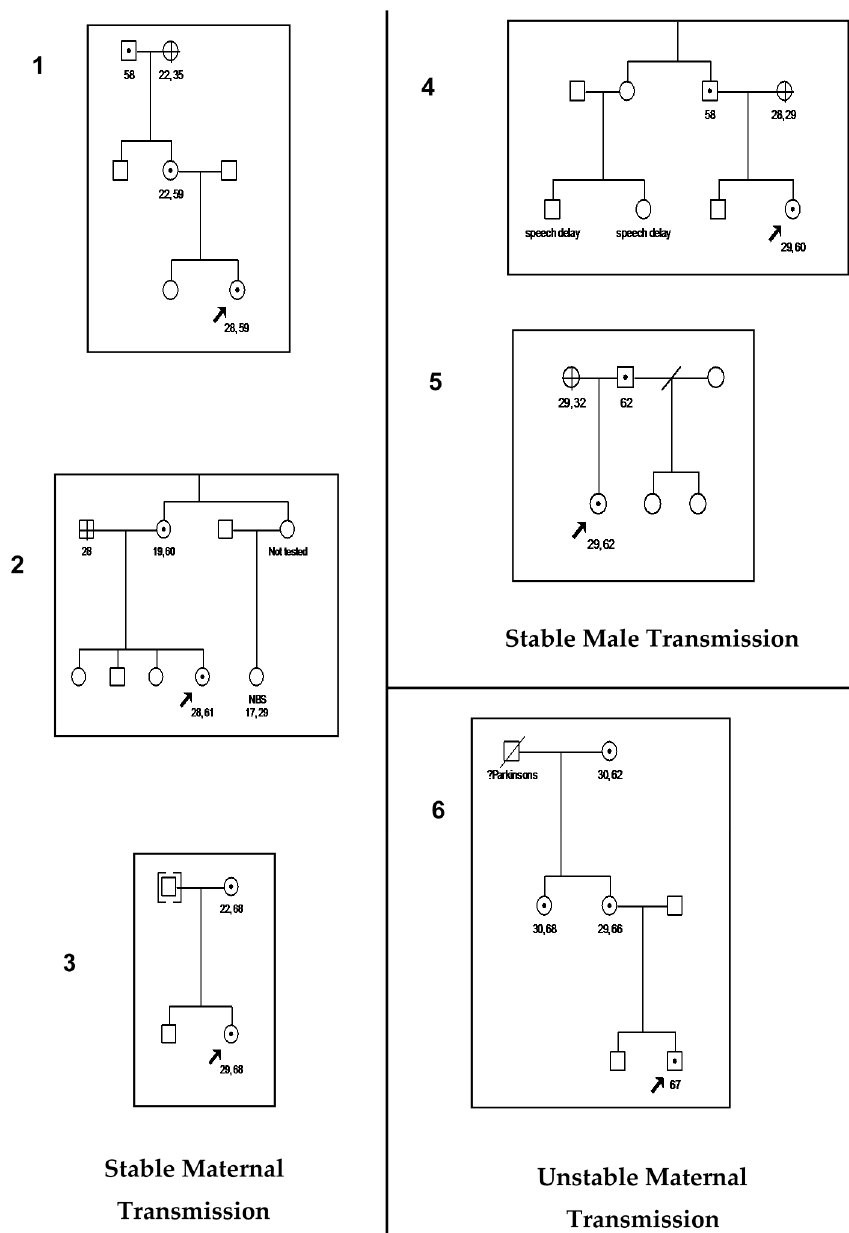
Figure A1. Pedigrees for Cases 1–6.